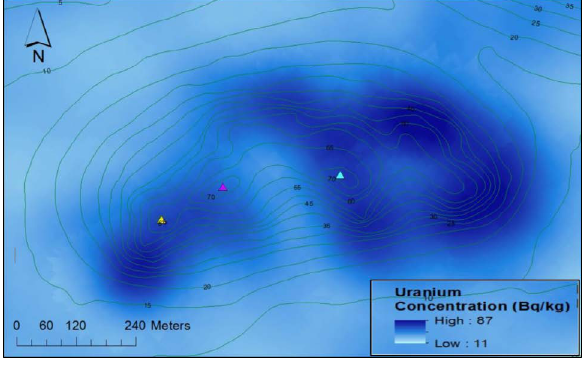
Figure 5: Uranium concentration overlaid on a topographic map of Baviaansberg.